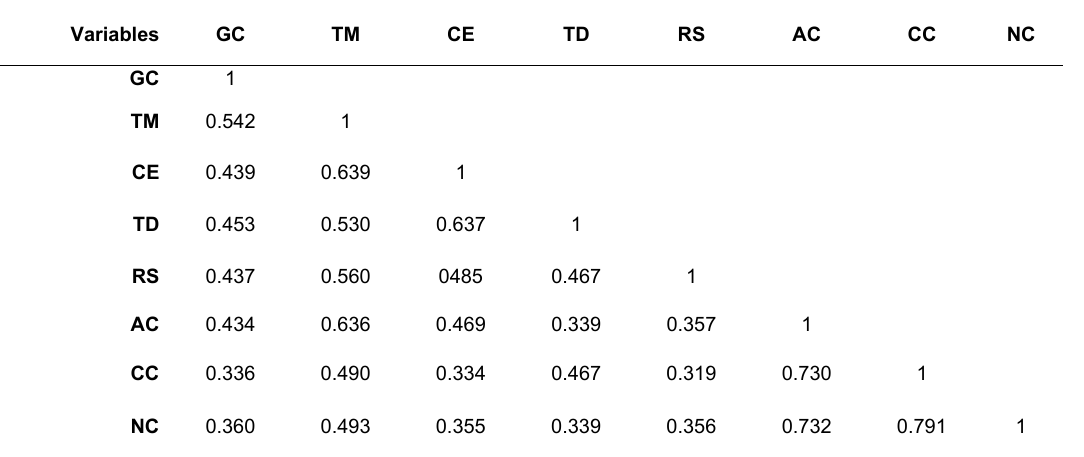
Table 7. Inter-variable